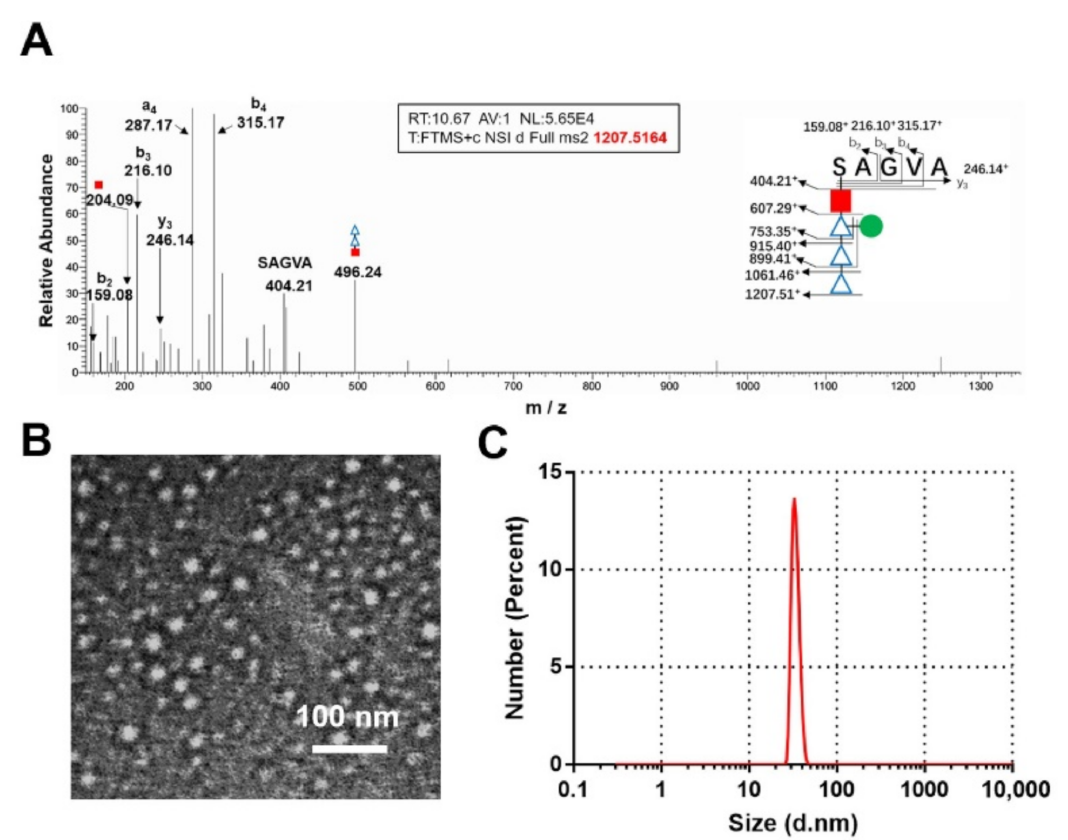
Figure 3. Characterization of NP-RU. ( A ) Tandem mass spectrometry (MS/MS) analysis of NP- RU. MS/MS spectrum of singly charged ions at m / z 1207.51 + contained the pentapeptide SAGVA ( m / z 404.21 + ) and a peptide linked with sugars. The peptide and glycopeptide fragment ions were identified (shown in the inset). ( B ) TEM images of NP-RU. ( C ) DLS analysis of